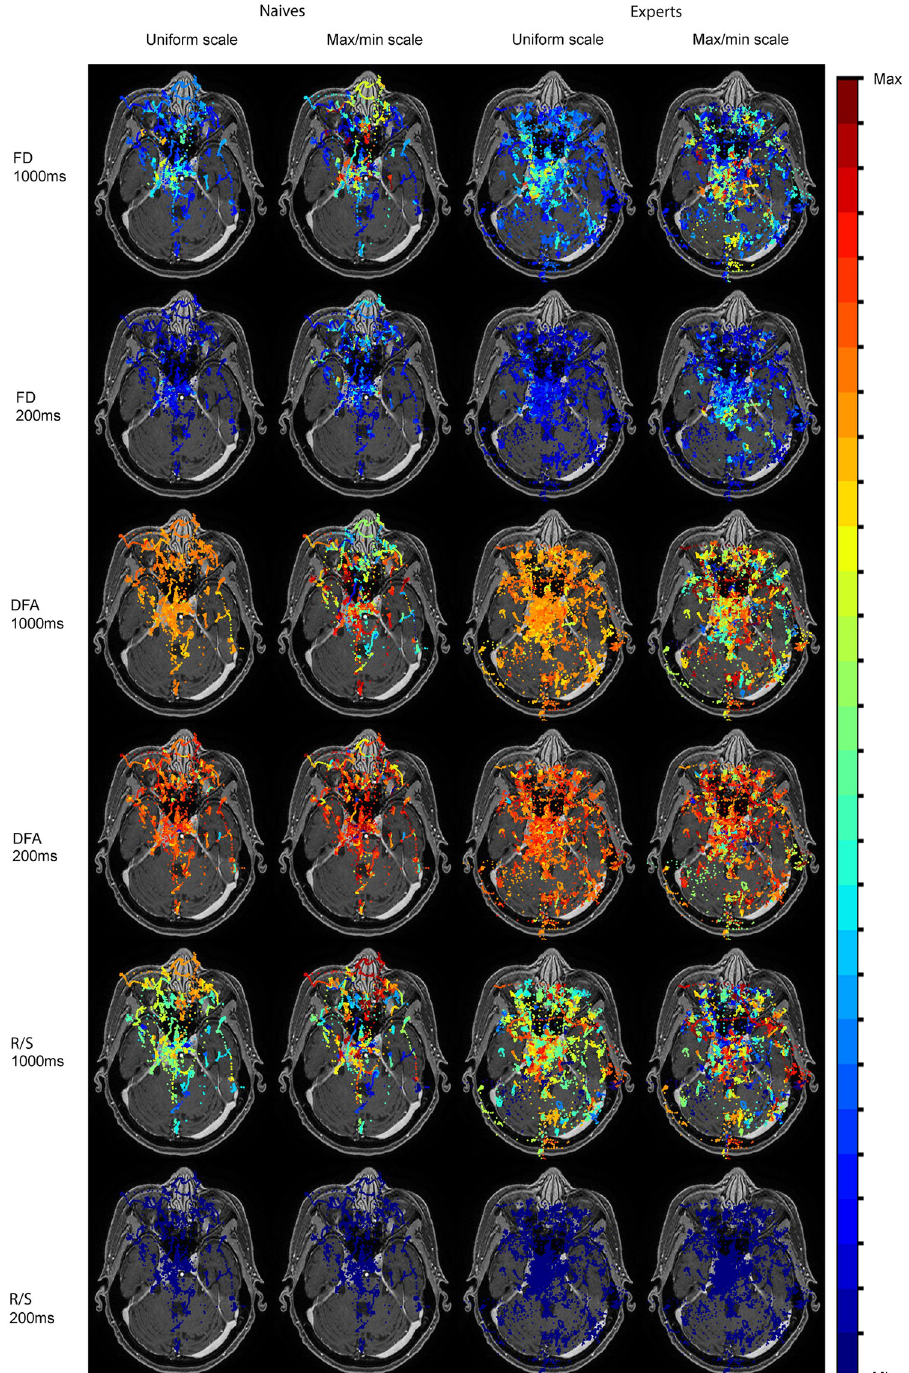
Fig 5. Heat maps of FD, R/S and DFA for a stimulus using eye-tracking data from Na ï ves and expert (Brain- experts and Other-experts) groups. The parameters were evaluated by sliding with time slots of 1000 ms and 200 ms over the full viewing duration of 5000 ms. The values of the parameters were uniformed for the uniform scale while max/min scale keeps the original values for each participant.